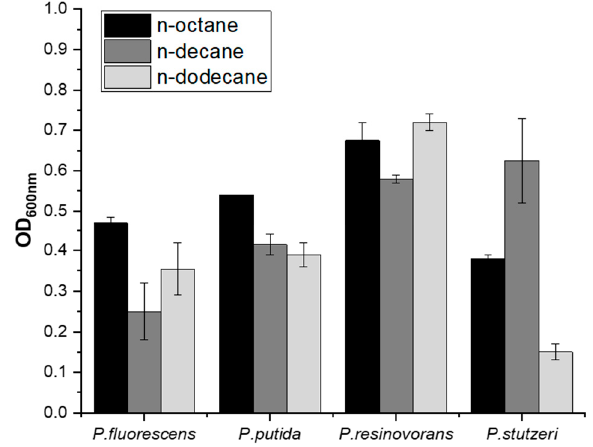
Figure 1. Cell growth of Pseudomonas species using n-octane, n-decane, and n-dodecane as a sole carbon source. Each alkane is present as 10% ( v / v ) in minimal medium.